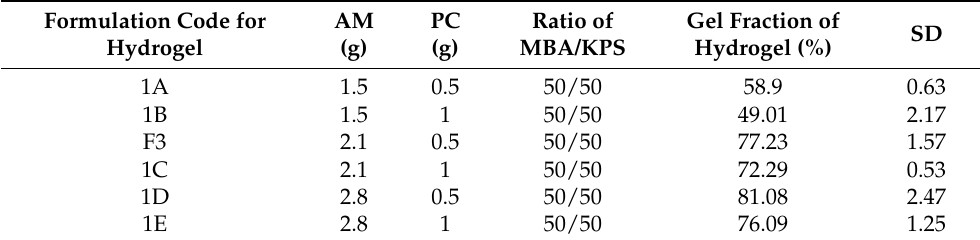
Table 1. Gel fraction of PC/polyacrylamide hydrogel based on different amounts of acrylamide and PC with a constant ratio of MBA/KPS.